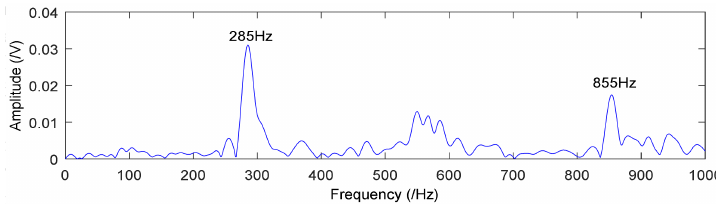
Figure 31. The diagonal slice spectrum of the original signal.